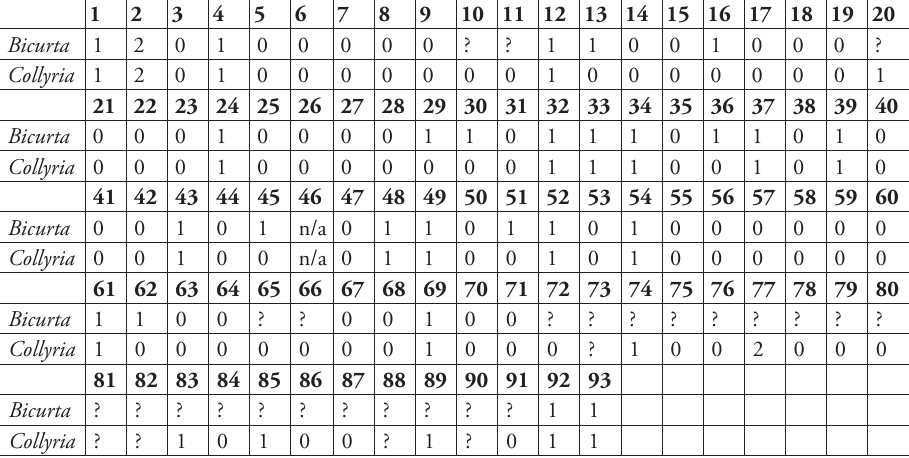
table 1. Character codings for Bicurta and Collyria ; characters 1-91 are from Wahl and Gauld